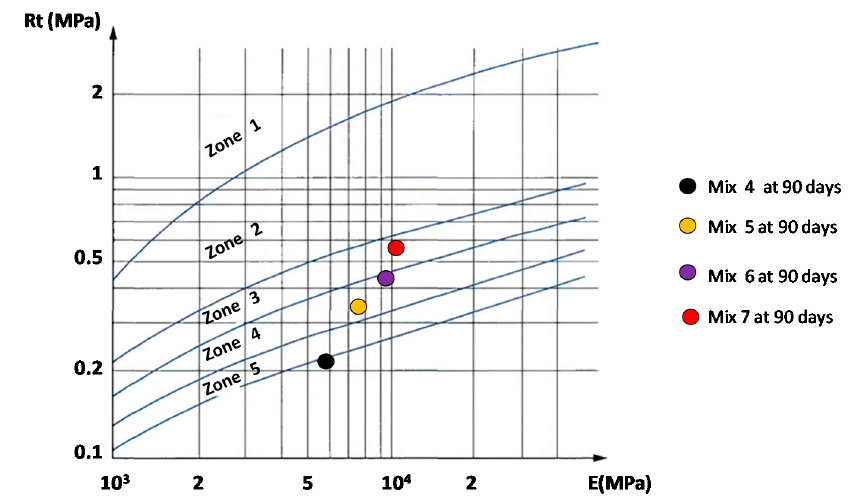
Figure 8. Classification zones of the designed mixes according to the ( E , Rt) at 90 curing ages [35].